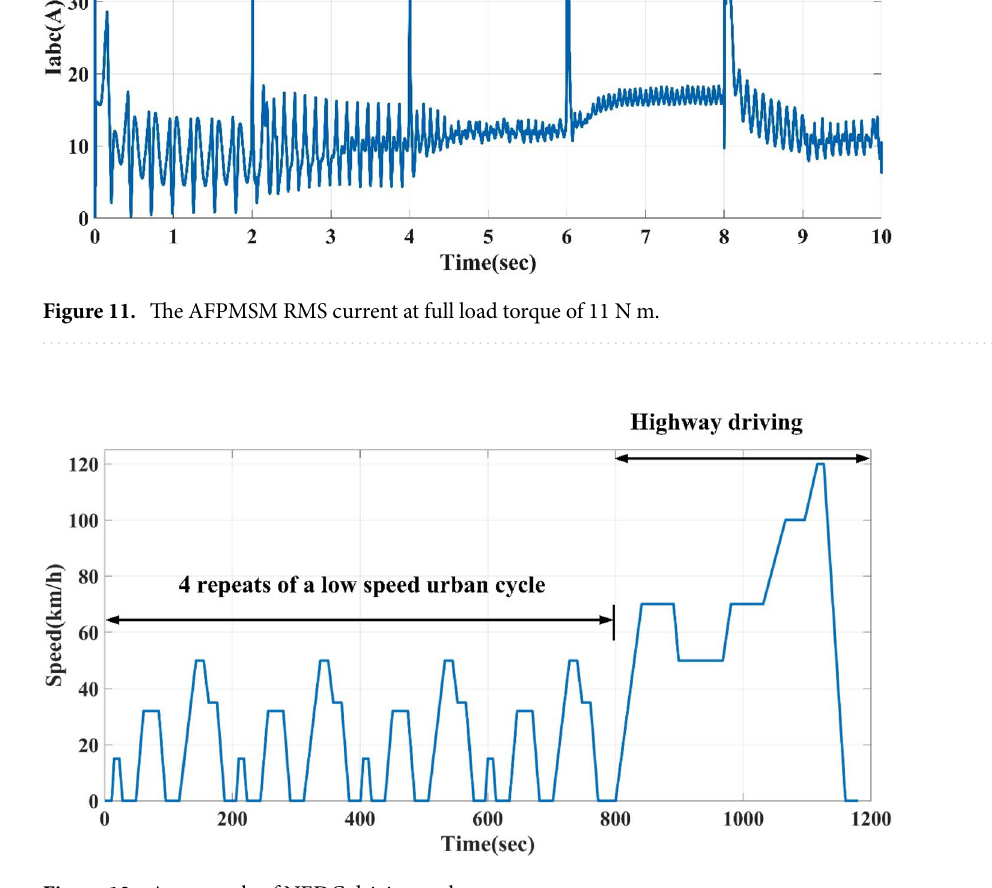
Figure 12. An example of NEDC driving